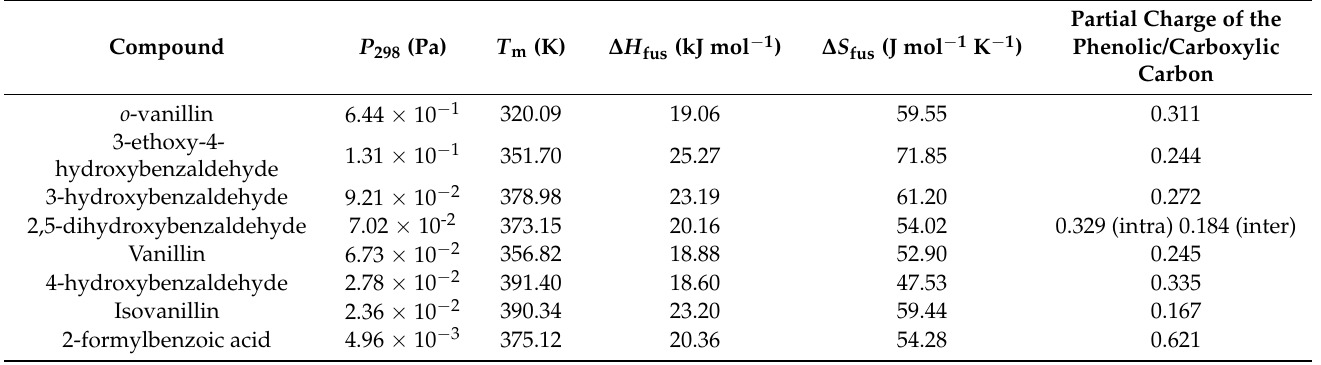
Table 3. P sat at 298 K, melting point, enthalpy of fusion, entropy of fusion, and the partial charge of the phenolic carbon of L the H-bonding benzaldehydes (carboxylic carbon in the case of 2-formyl-benzoic acid).